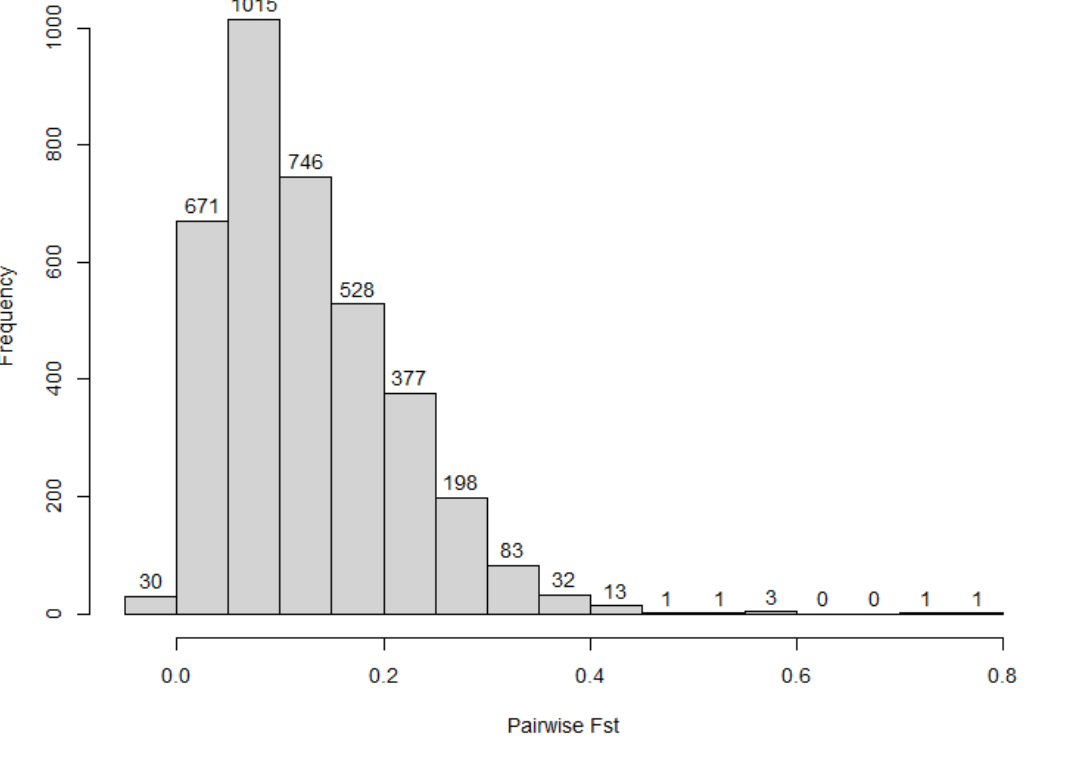
Figure 8. Population pairwise Fst value. Table 5. List of accessions with DOI identifiers and origin contained in the subset, developed using SNP